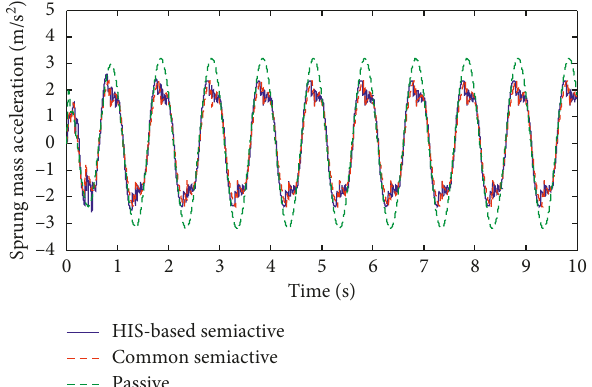
Figure 17: Body vertical acceleration comparison between the common semiactive control suspension and the proposed semiactive control suspension.